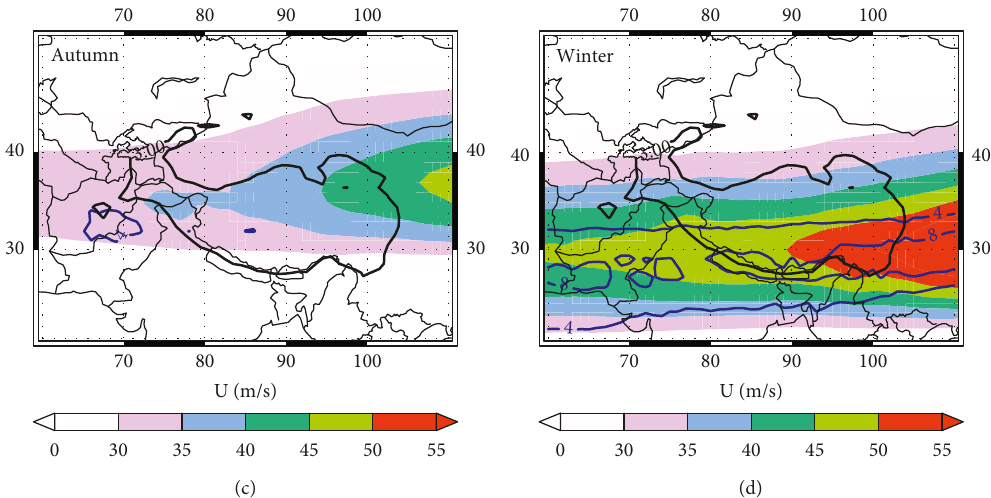
Figure 7: Seasonal mean U wind (color shadings) at 200hPa during 1979–2018. The blue contours represent 4% and 8% total tropopause fold frequencies. Black contours indicate the location of the TP.